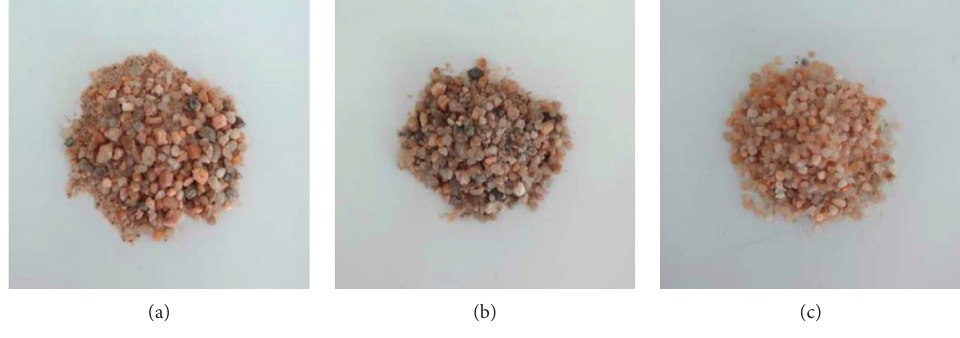
Figure 2: Samples of natural sand: (a) DS; (b) NS; (c) FS.